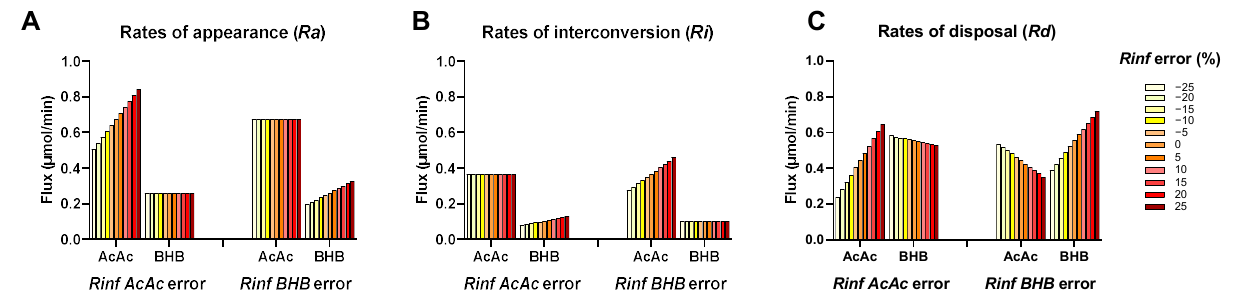
Figure 4. Effect of erroneous infusion rates on ( A ) rate of appearance, ( B ) rate of interconversion, and ( C ) rate of disposal estimated using the matrix solution of the two-pool ketone model (matrix method). The model is prone to errors since it assumes fidelity between tracer infusion rates and their dilution by endogenous ketone production and interchange.